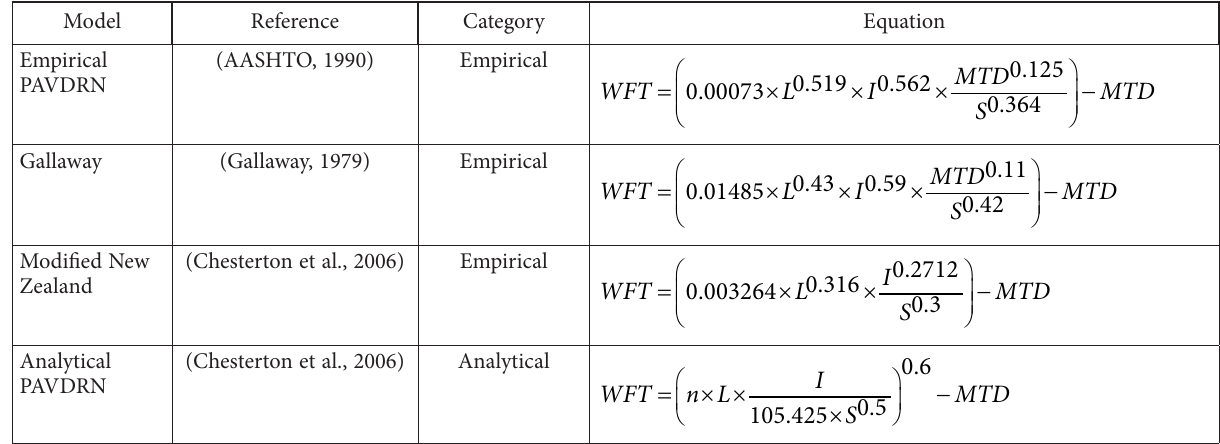
Table 1. Summary of the most common WFT prediction models (Luo et al.,